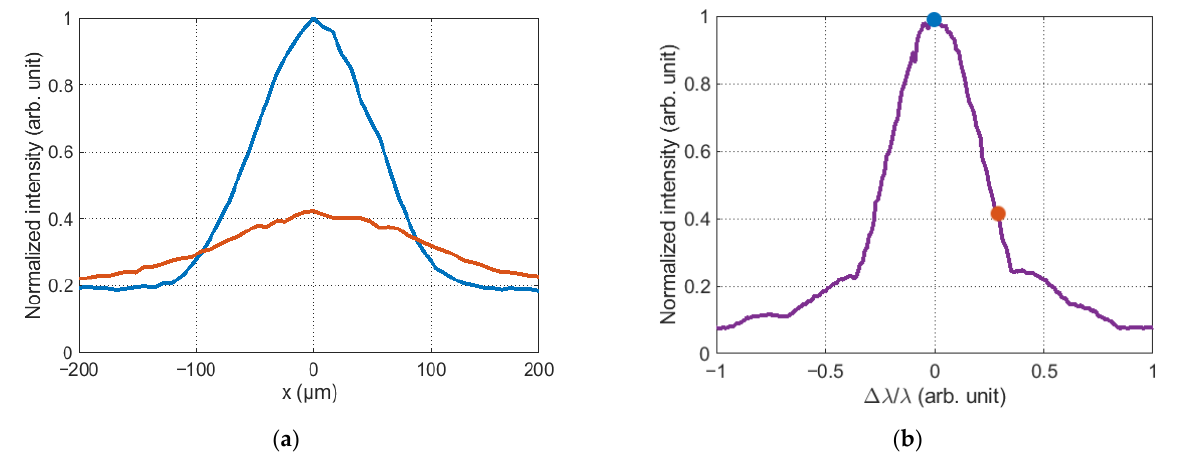
Figure 6. ( a ) Сross section of the correlation function from the Figure 5a,b; ( b ) normalized dependences of the amplitude of the maximum correlation response.